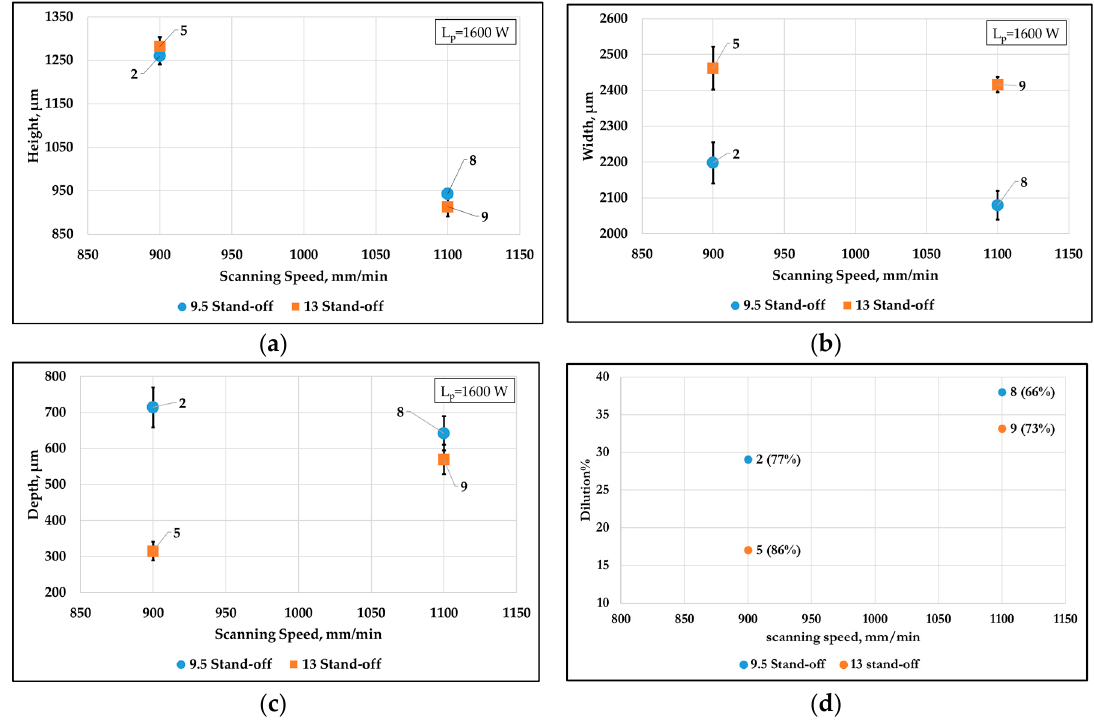
Figure 5. Influence of scanning speeds of 900 mm/min and 1100 mm/min on ( a ) height, ( b ) width, ( c ) depth, ( d ) %dilution of deposits at laser stand-off distances of 9.5 mm and 13 mm at a constant laser power of 1600 W.